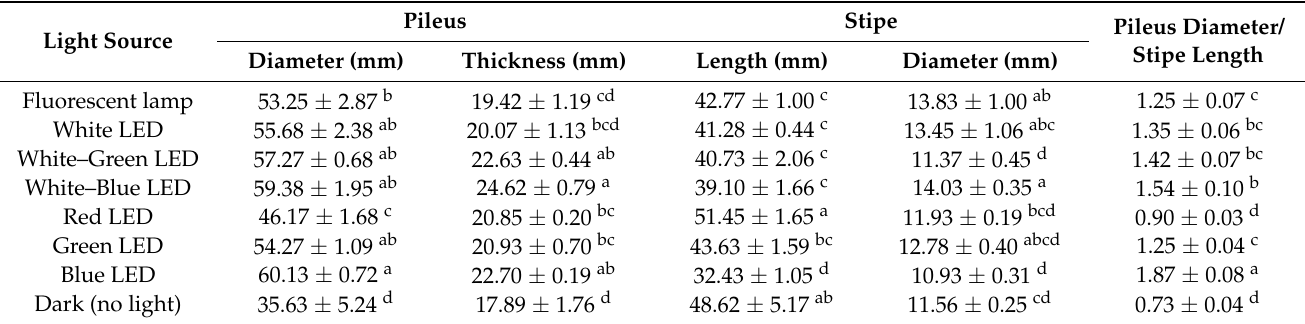
Table 1. Summary of morphological properties of the fruit body under different light